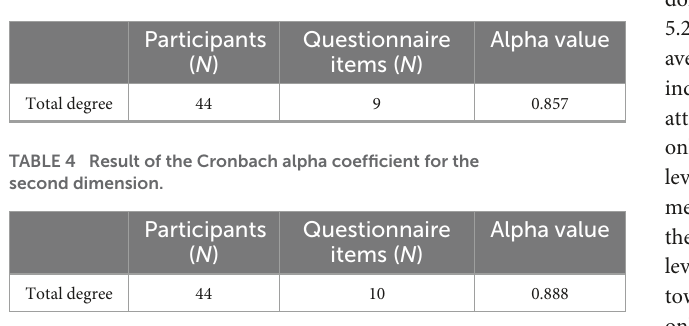
TABLE 5 Results of the Cronbach alpha coefficient for the two